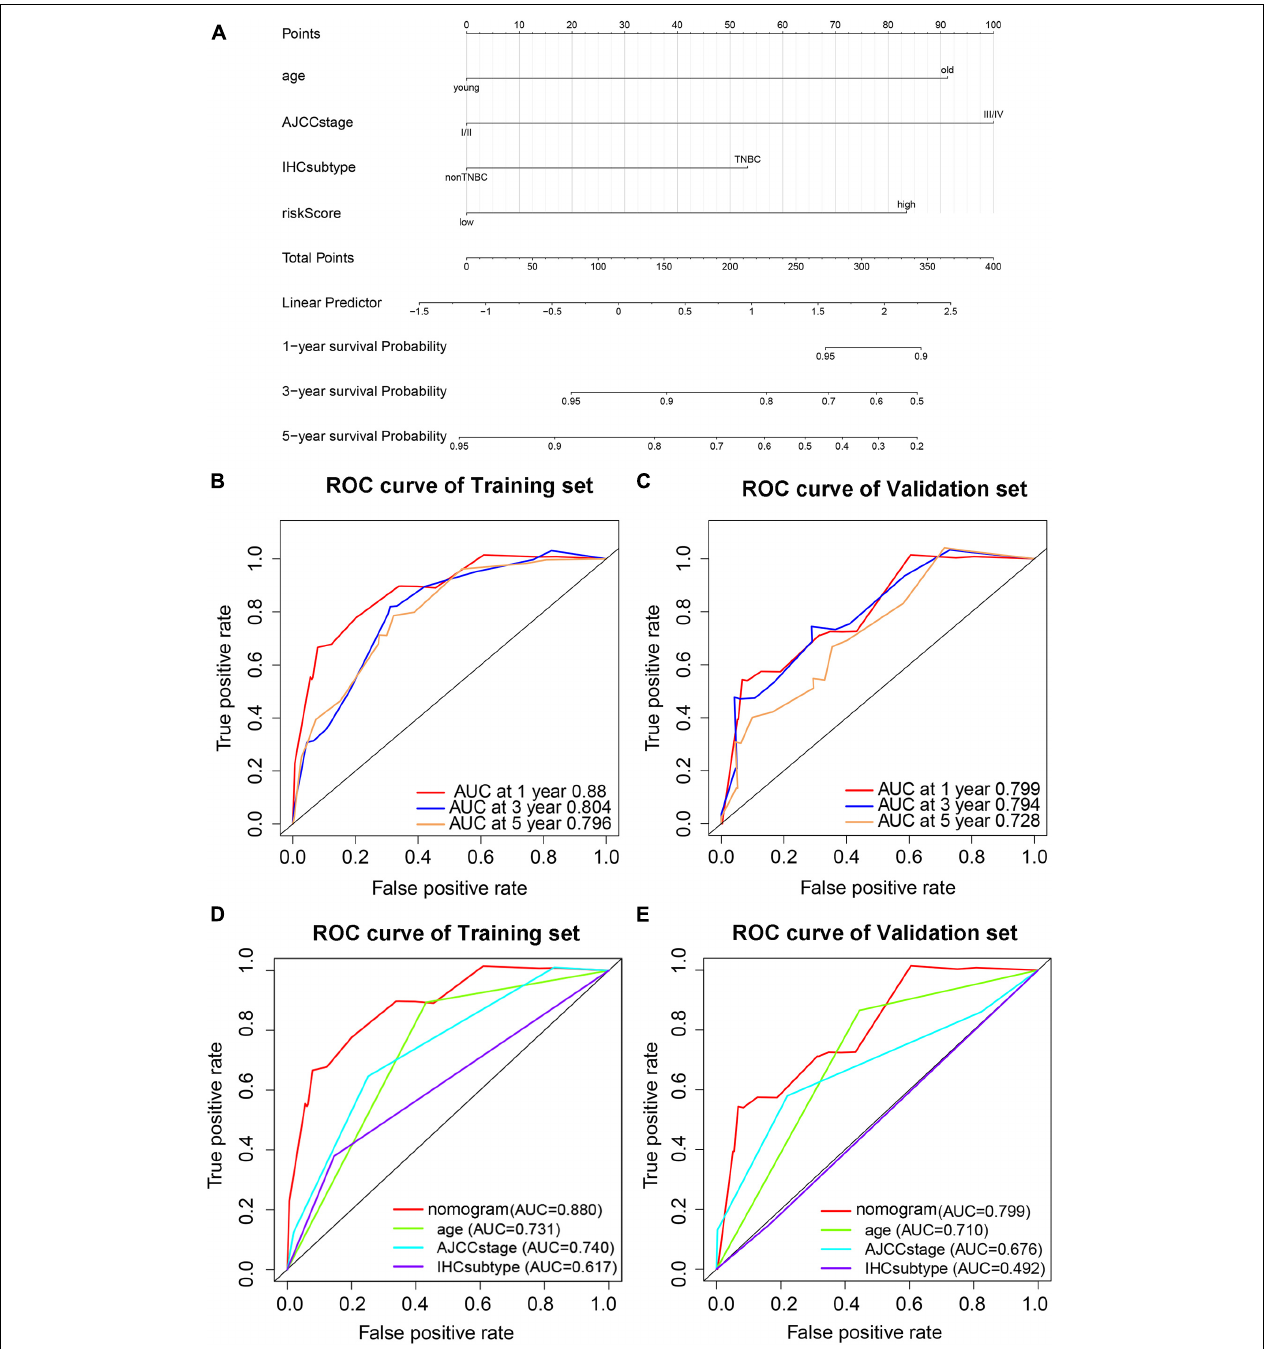
FIGURE 11 | Prediction model based on pyroptosis-associated lncRNA signature for OS of BC patients. (A) Nomogram prediction model for OS of BC patients. Time-dependent ROC curves predict 1-year, 3-year, and 5-year OS in the training set (B) and validation set (C) . Predictive value of the nomogram and traditional prognostic indicators are compared by ROC curve analysis in the training set (D) and validation set (E) .